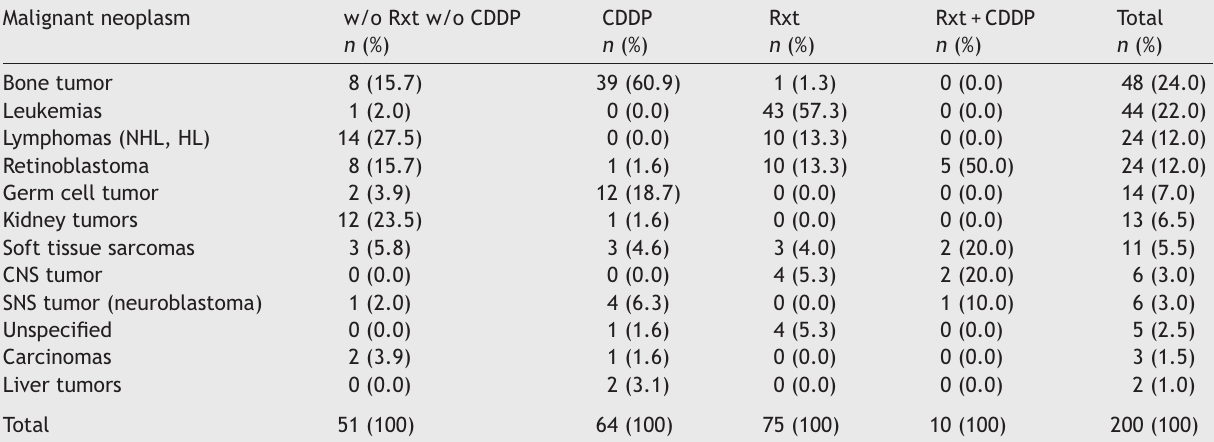
Distribution of patients, according to the type of primary cancer at diagnosis and treatment type (GEPETTO 2000---2004). Malignant